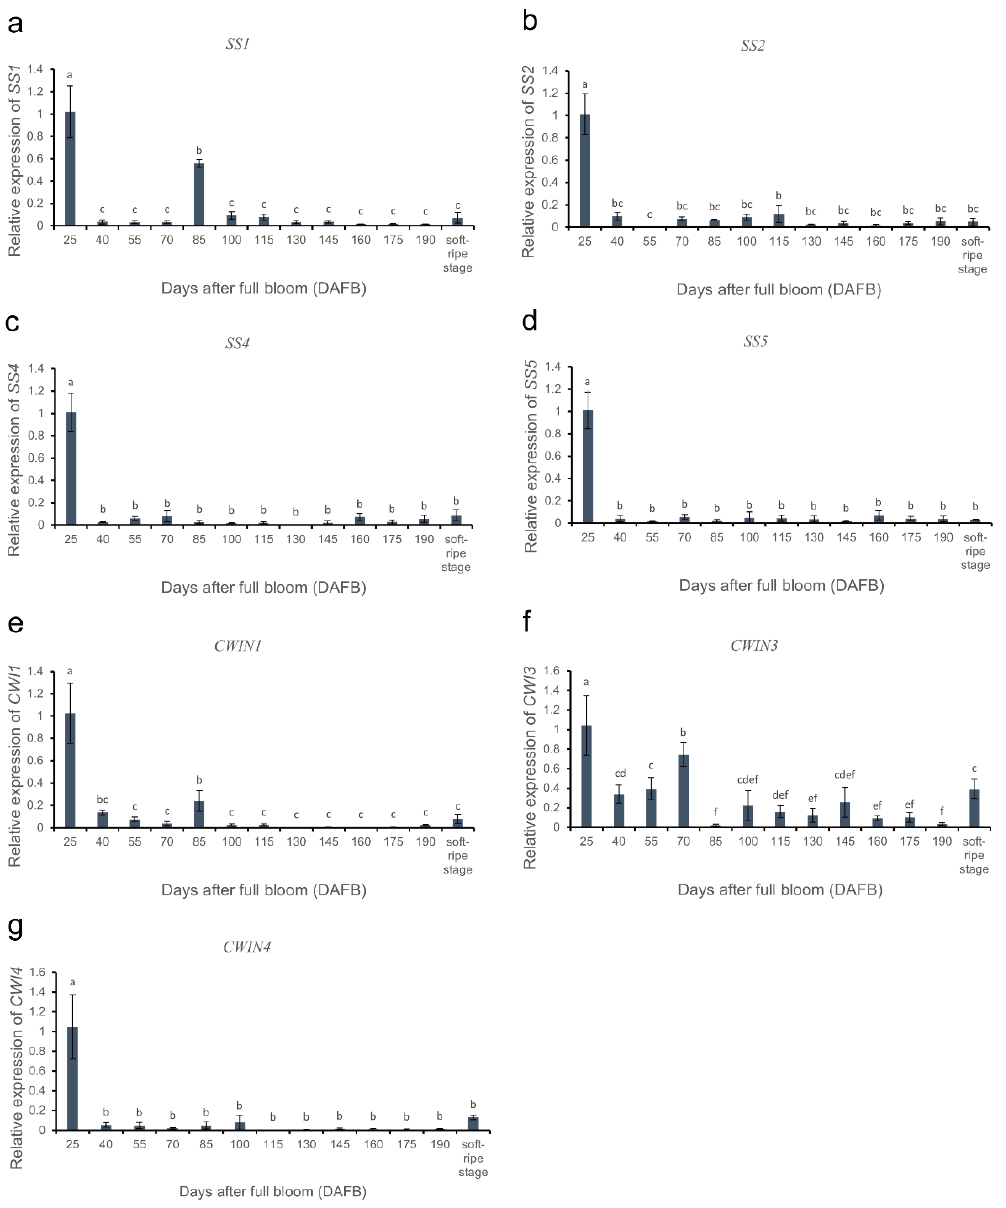
Figure 6. Expression patterns of sucrose metabolism-related genes over A. eriantha ‘Ganlv 1’ fruit development, including SS1 ( a ); SS2 ( b ); SS4 ( c ); SS5 ( d ); CWIN1 ( e ); CWIN3 ( f ) and CWIN4 ( g